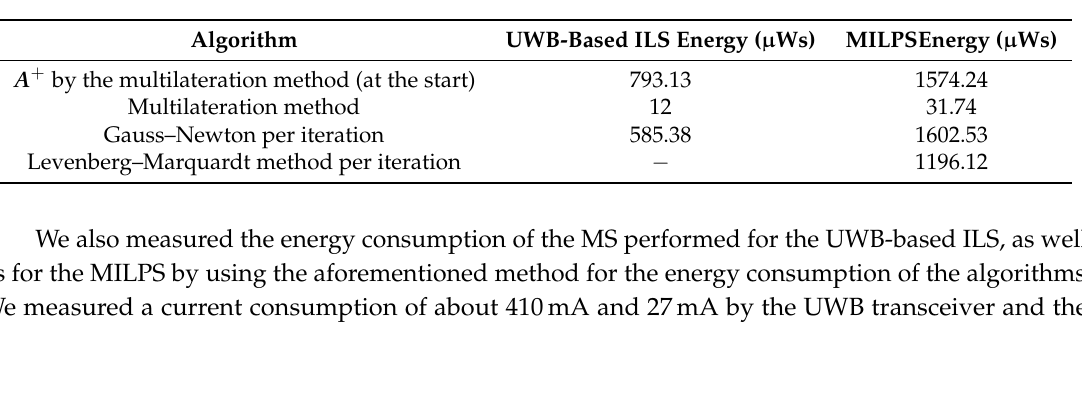
Table 9. List of measured energy consumption values of the algorithms by the UWB-based ILS and